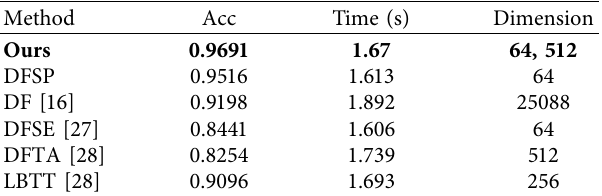
Table 5: Comparison with existing visual search approaches on the NTU.